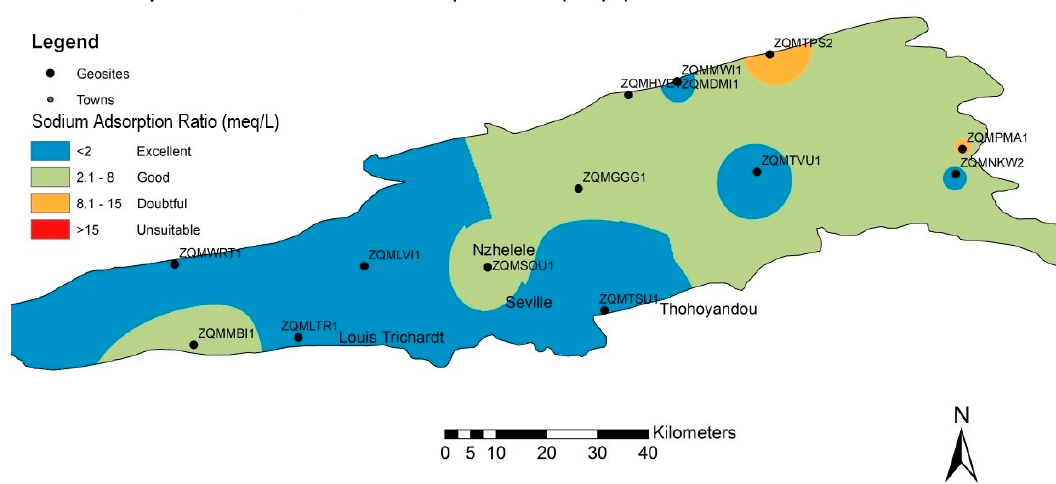
Figure 9. Spatial distribution of suitability of groundwater for irrigation based on SAR.